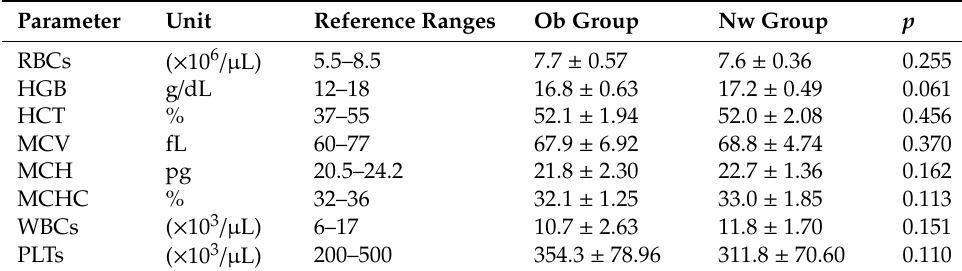
Table 3. Haematological results in Obese and Normal-weight dogs.